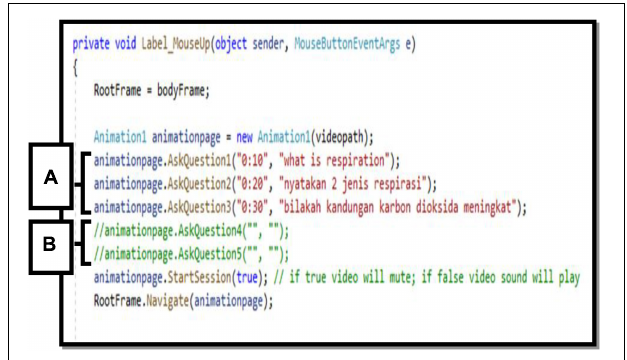
FIGURE 5 | C# Programming sheet in visual